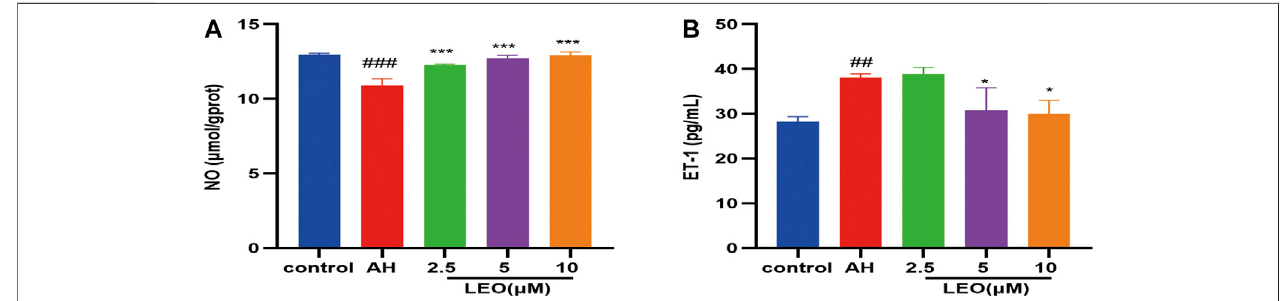
Frontiers in Pharmacology |